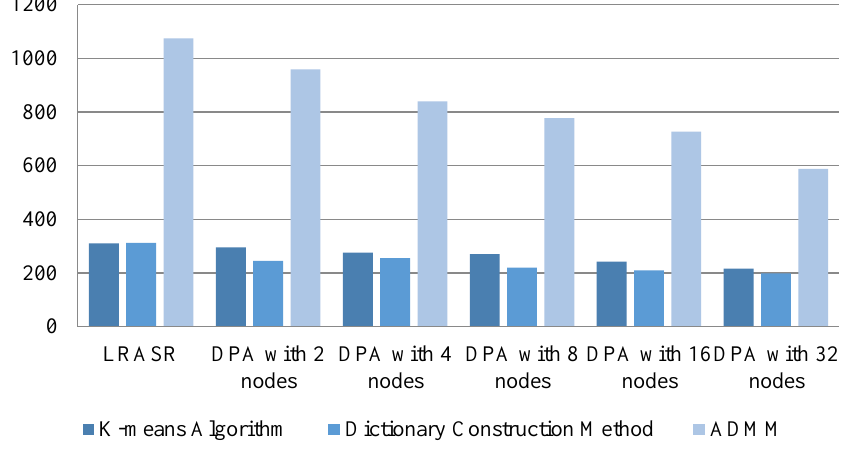
Figure 9. Memory consumption (MB) of LRASR and DPA with different number of nodes in Experiment